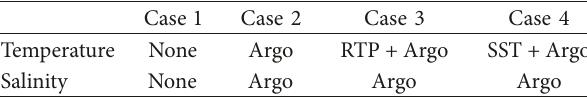
Table 1: Summary of assimilation data in cases